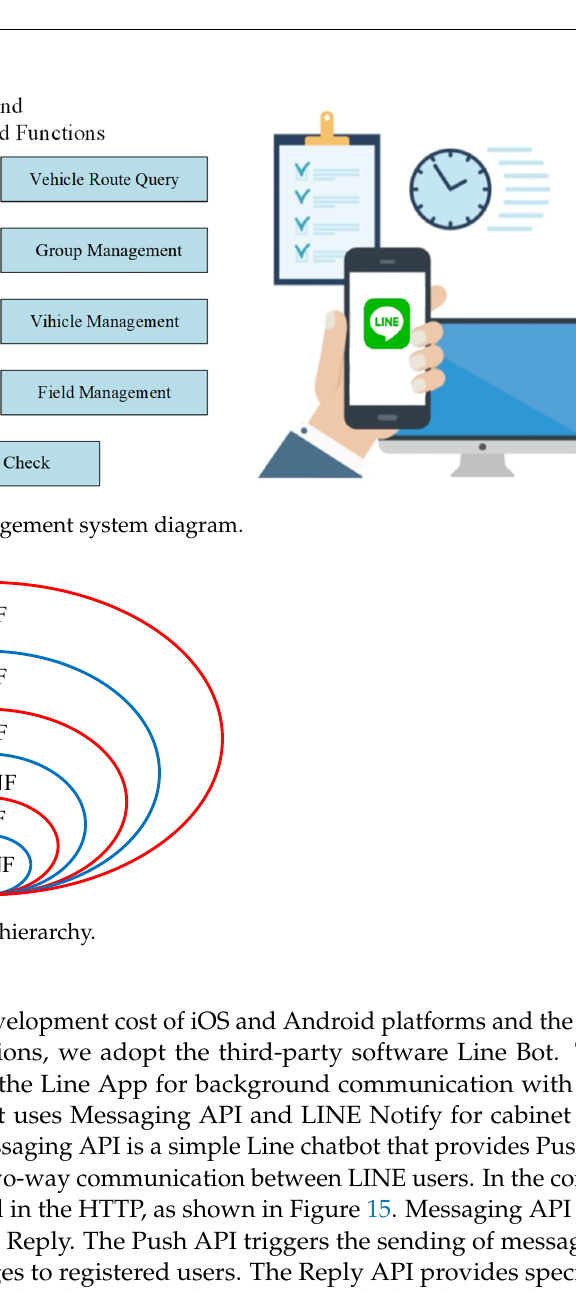
Figure 14. Regularization hierarchy.